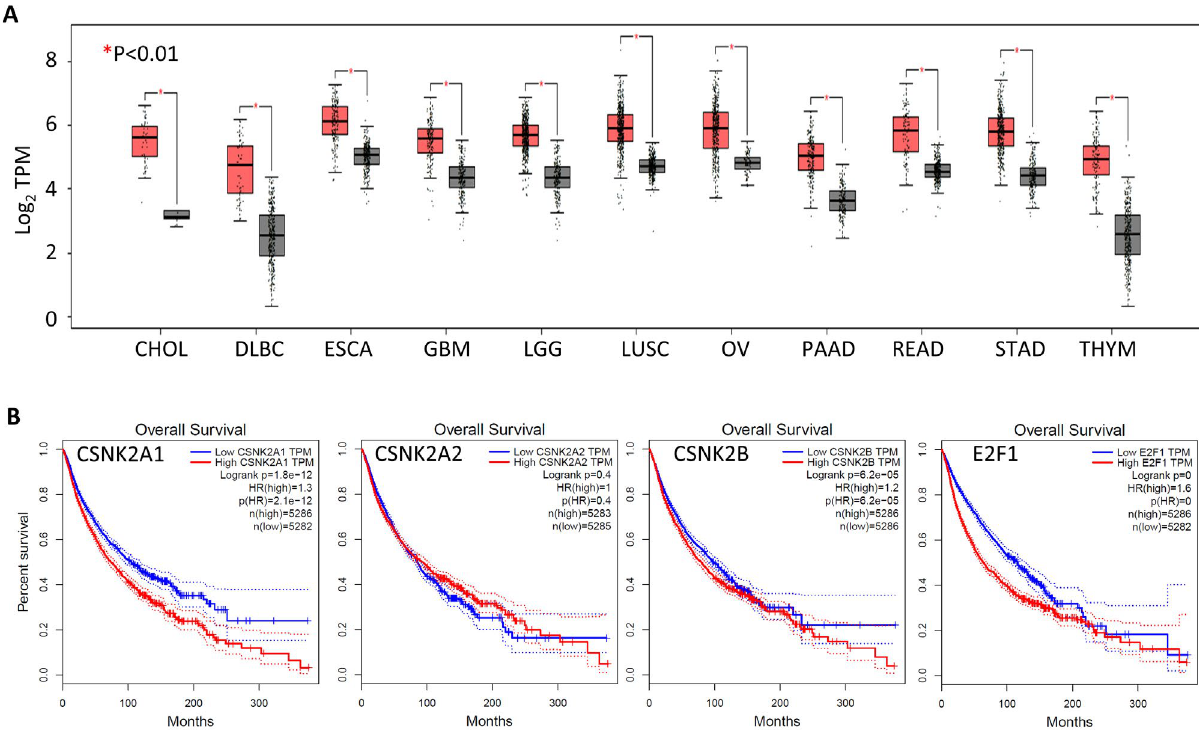
Figure 1. High CSNK2A 1 mRNA expression is associated with reduced overall survival across cancer types. (A) Box plot of CSNK2A1 mRNA expression levels in multiple cancer types. In each case tumor samples are in red and normal samples are in black. Only tumor types with a statistically significant difference in expression between cancer and control samples ( P < 0.01) are shown. TPM: transcripts per million; CHOL: cholangiocarcinoma; DLBC: diffuse large B-cell lymphoma; ESCA: esophageal carcinoma; GBM: glioblastoma multiforme; LGG: lower grade glioma; LUSC: lung squamous cell carcinoma; OV: ovarian serous cystadenocarcinoma; PAAD: pancreatic adenocarcinoma; READ: rectum adenocarcinoma; STAD: stomach adenocarcinoma; THYM: thymoma; (B) Kaplan-Meier survival analysis of mRNA expression versus overall survival for CSNK2A1 , CSNK2A2 , and CSNK2B (with E2F1 shown for comparison) across all TCGA cancer types. In each case, low expression is shown in blue and high expression is shown in red. High CSNK2A1 , high CSNK2B , and high E2F1 expression are all associated with reduced overall survival. All data were obtained using GEPIA2 from TCGA data sets. E2F1: E2F transcription factor 1; GEPIA2: gene